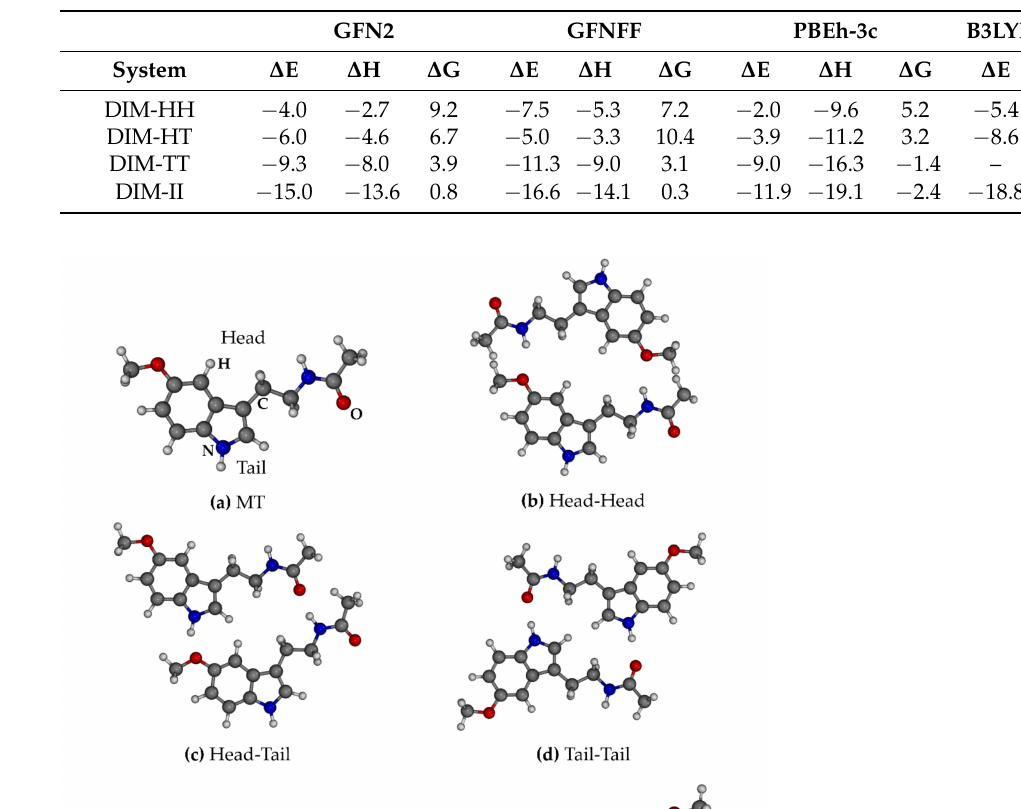
Table 2. Dimerization energy ( ∆ E), enthalpy ( ∆ H) and free energy ( ∆ G) of melatonin dimers (DIM), in all the studied conformations: Head–Head (HH), Head–Tail (HT), Tail–Tail (TT) and Indole–Indole (II). Values are in kcal/mol.